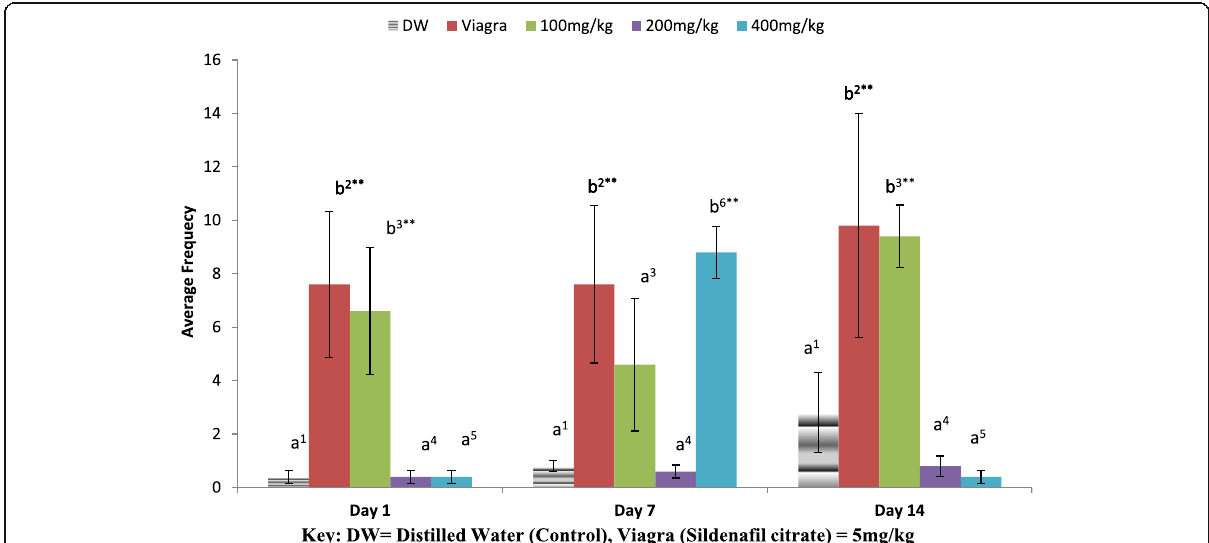
Fig. 2 Effect of ethanol extract of A. barbadensis root on intromission frequency of male rats. Bars with unlike letters are significantly different from each other on each day. Bars with dissimilar numbers for the same dose group at different days are significantly different. All values are expressed as Mean ± SEM; n = 5;** P < 0.01; * P <